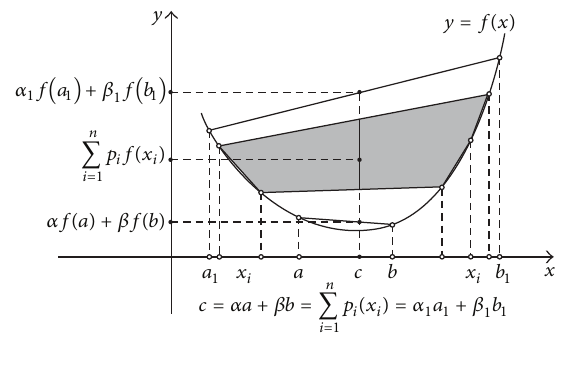
Figure 1: Line convex combinations with the same center 𝑐 .